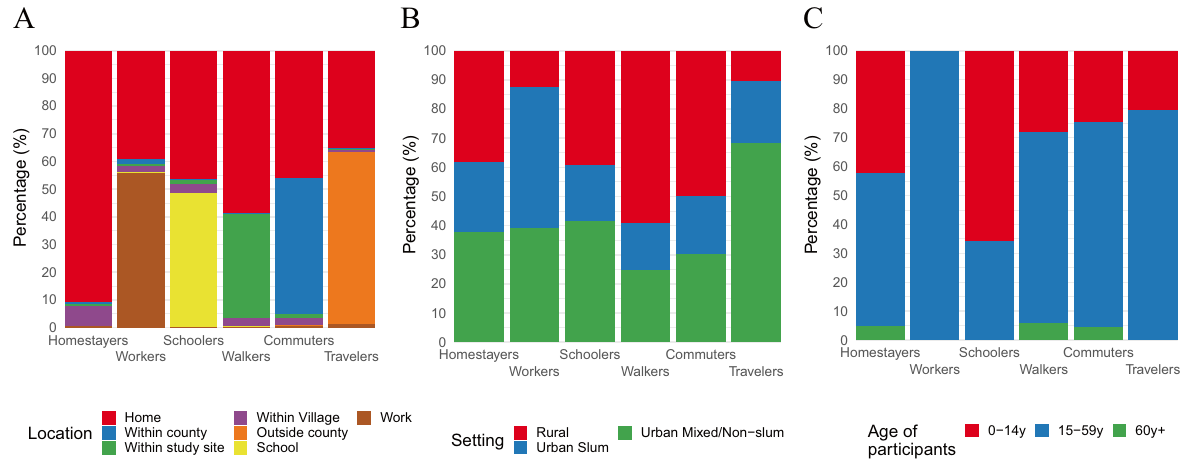
Figure 3. Description of the six TU profile groups by location ( A ), setting ( B ), and age group ( C